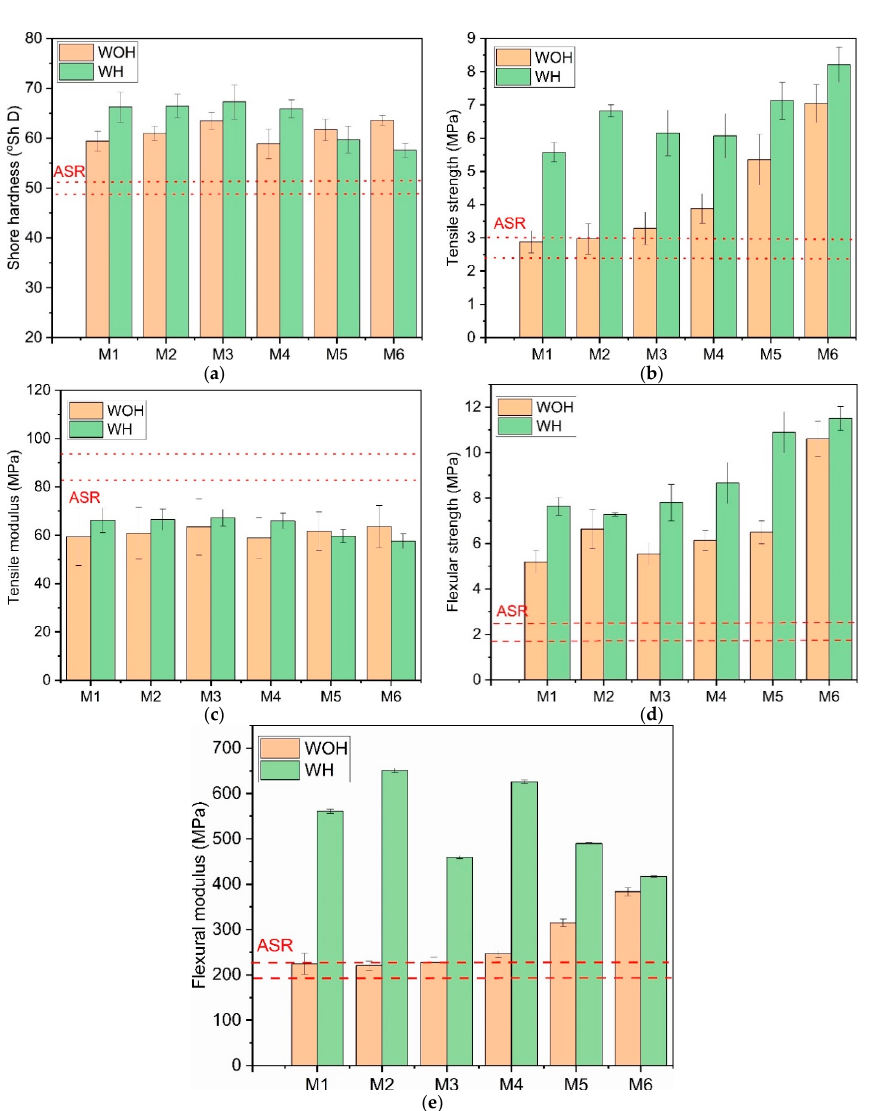
Figure 6. Mechanical properties of composites without homogenization and with homogenization: ( a ) Shore hardness, ( b ) tensile strength, ( c ) tensile modulus; ( d ) flexural strength, and ( e ) flexural modulus. Tensile strength for ASR blends (Figure 6b) increased when recycled LDPE was added, and increased with the addition of PE-g-MAH, indicating that a small amount of 5 wt % PE-g-MAH leads to better interfacial adhesion between the blend components [37]. As shown in Figure 6, the ASR-based compositions subjected to homogenization (WH) have significantly higher tensile (Figure 6b) and flexural strength (Figure 6d) compared to material series manufactured without preliminary mixing with high shearing